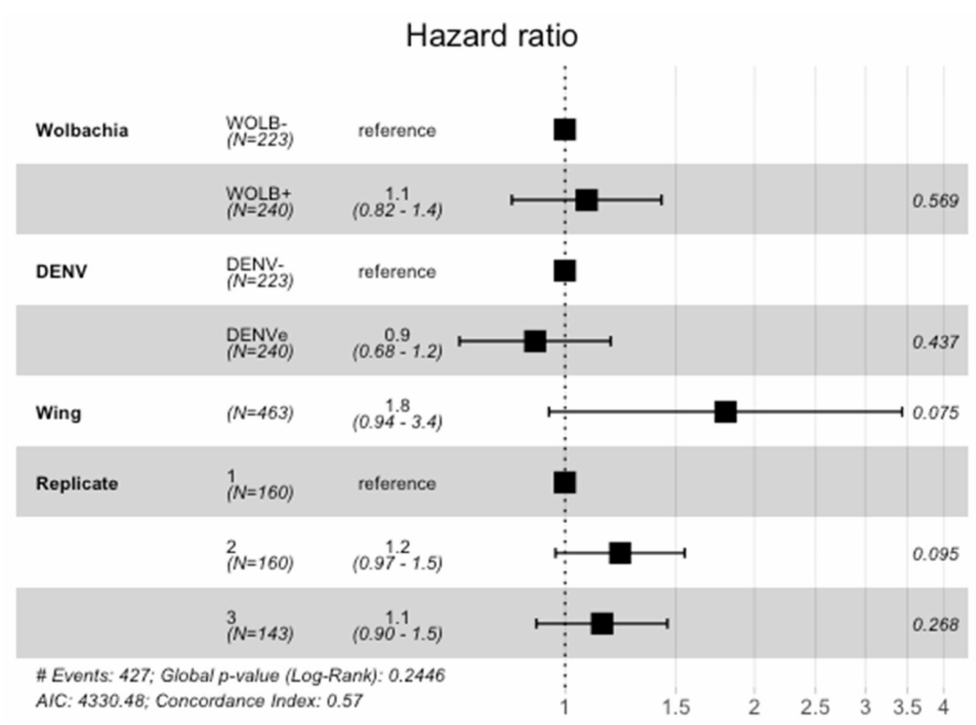
Figure 3. The effects of Wolbachia presence, DENV exposure, wing length and experimental replicates in mosquito survival expressed as hazard ratios (black squares) with 95% confidence intervals (bars) obtained from multivariate Cox model. Covariate p -value is expressed after confidence interval bars. Interaction between Wolbachia presence and DENV exposure status: hazard ratio = 0.9 (0.6–1.3), p = 0.56.